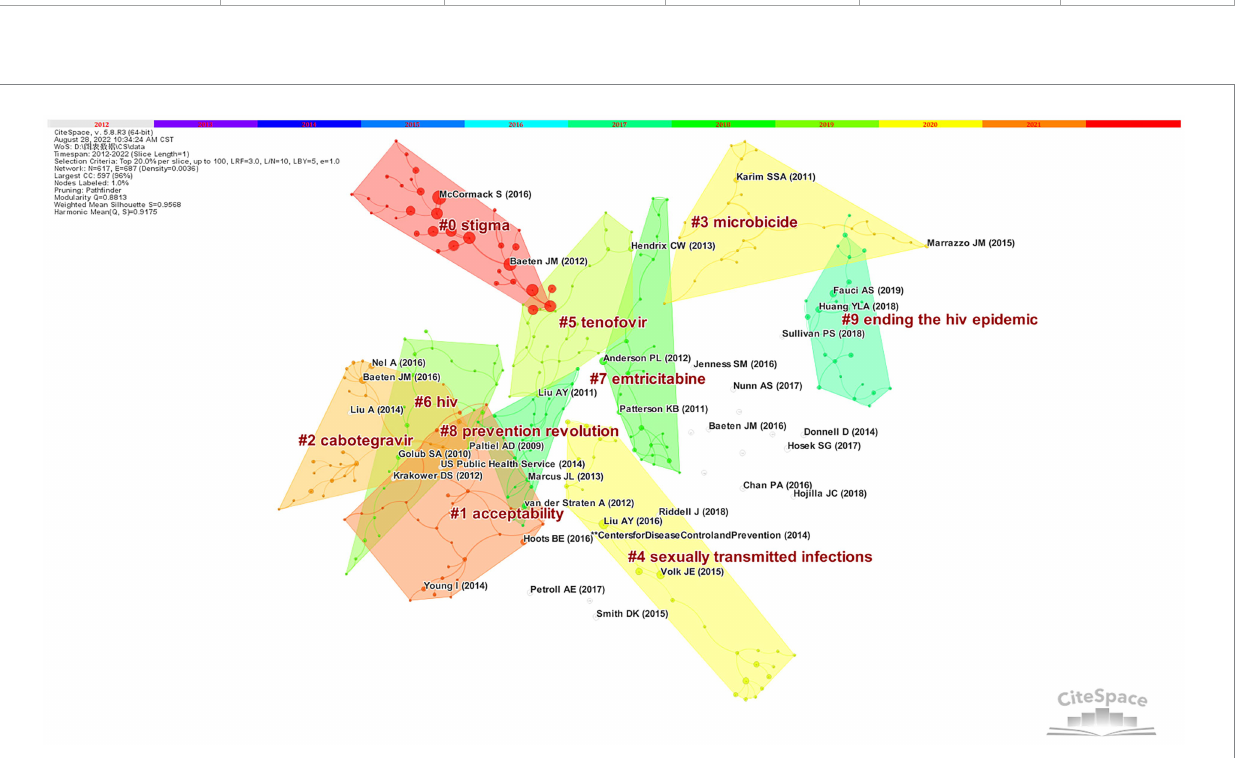
FIGURE 6 Cluster visualization based on the reference cocitation